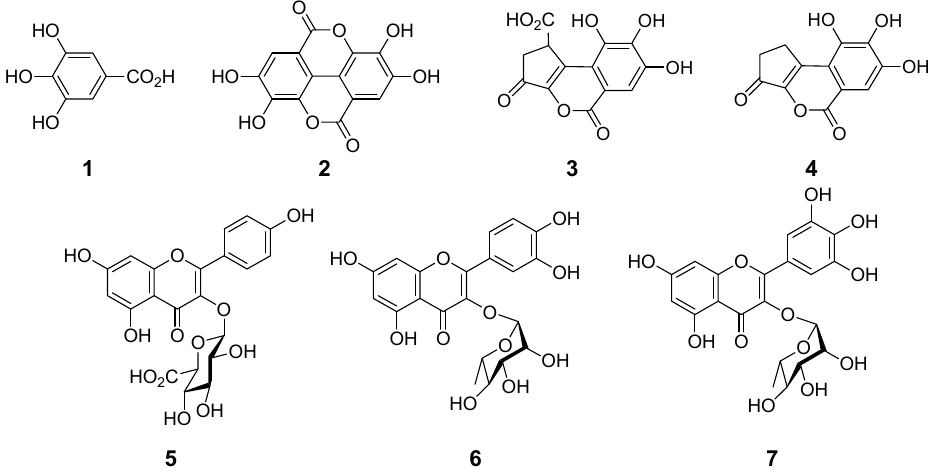
Figure 2. Structures of polyphenols isolated from insect tea: ( 1 ) Gallic acid; ( 2 ) ellagic acid; ( 3 ) brevi- folin carboxylic acid; ( 4 ) brevifolin; ( 5 ) kaempferol 3- O -glucuronide; ( 6 ) quercetin 3- O -rhamnoside; and ( 7 ) myricitrin 3- O -rhamnoside.